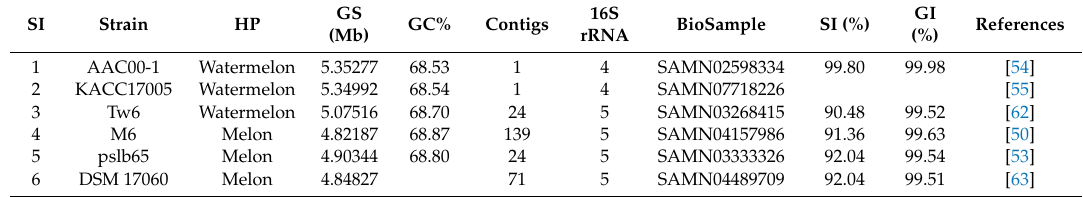
Table 2. Genomic information of A. citrulli strains used for whole-genome